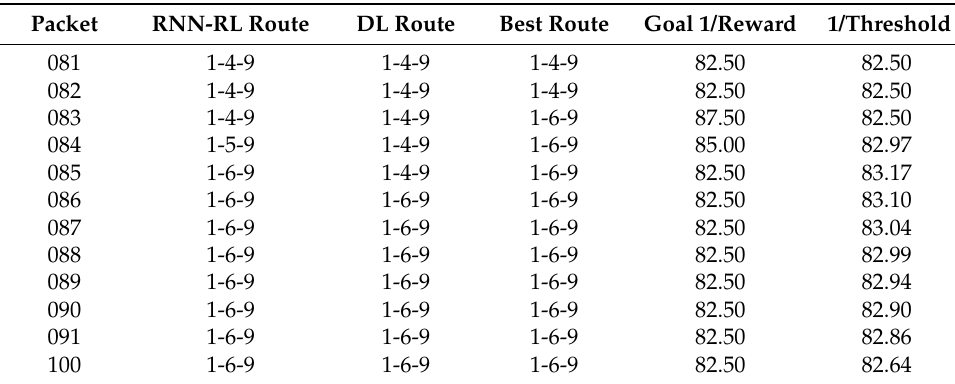
Table 7. Goal: 0.5 × Delay + 0.5 × Loss (3 × 3 Nodes).